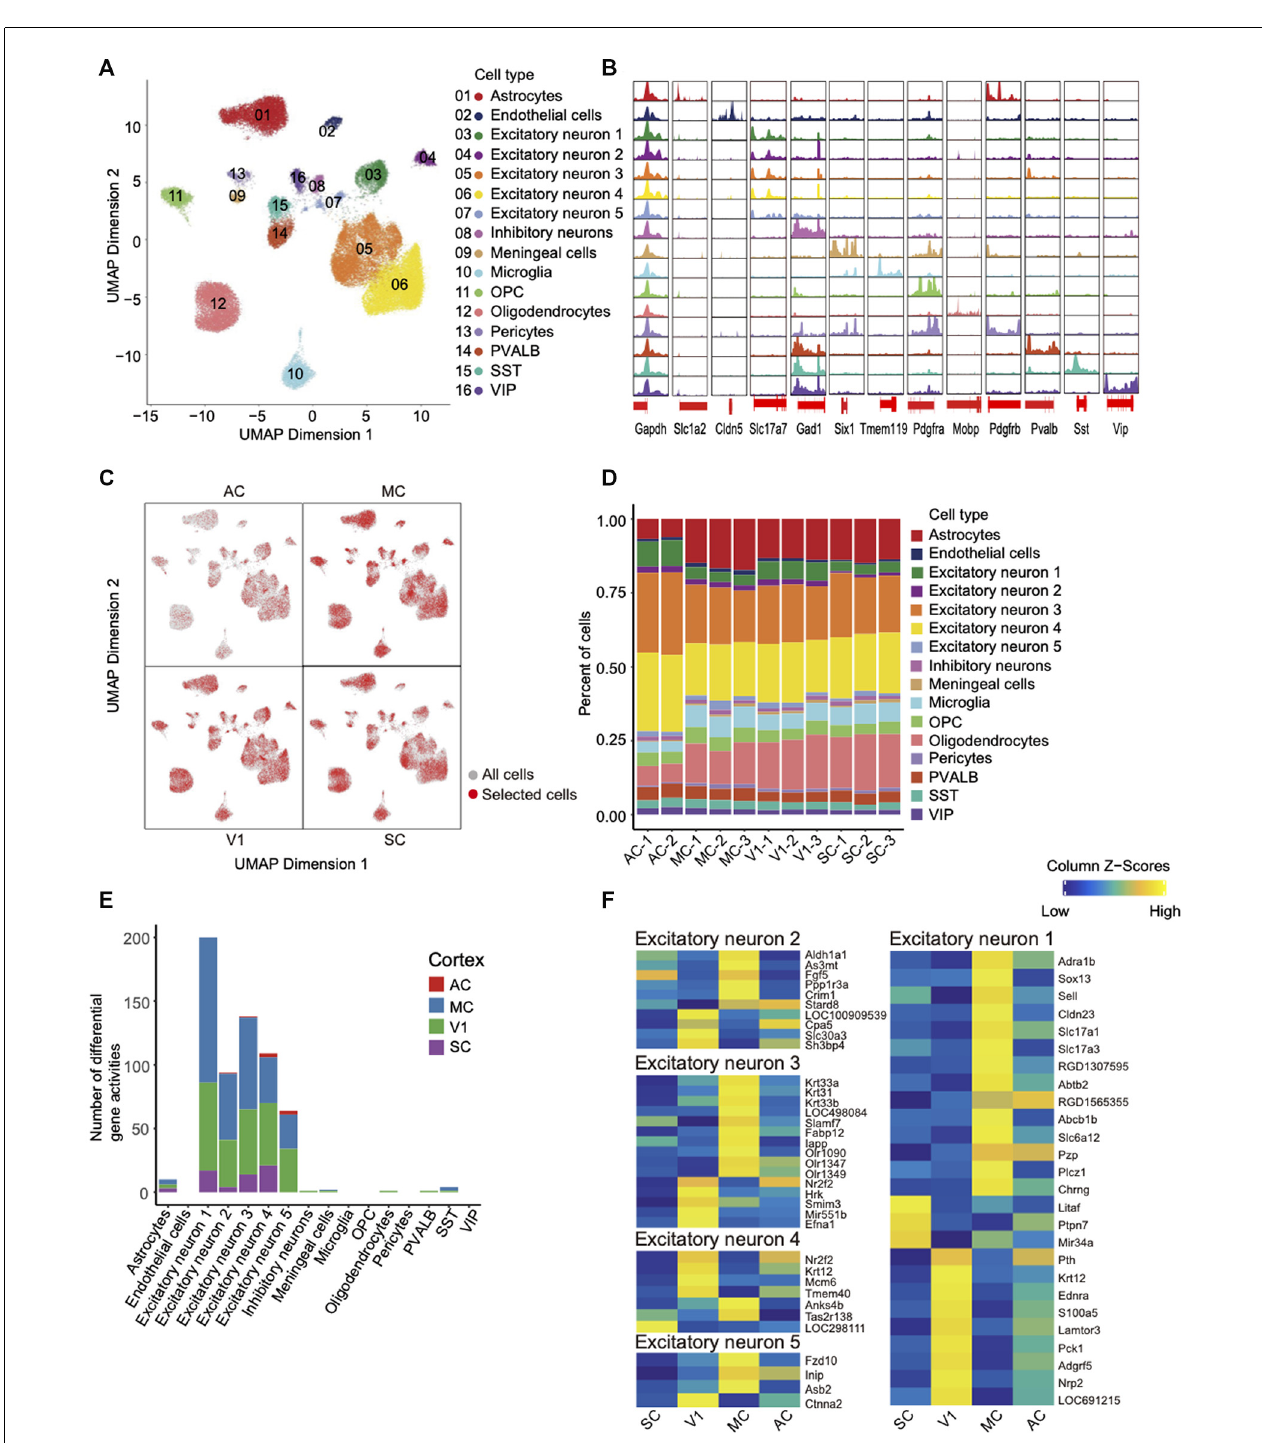
FIGURE 3 | Single-cell chromatin accessibility of rat cortex and inter-regional diversity of excitatory neurons. (A) UMAP of snATAC-seq data showing 16 clusters. A total of 59,023 nuclei passed QC and were used for clustering rat cortices into neuronal and non-neuronal cell types. Each cluster is color-coded to distinguish specific cell types. (B) Genome browser views of snATAC-seq signal for the indicated housekeeping gene (Gapdh) and cell-type-specific genes. (C) UMAP expresses differences in cellular distribution across the four cortex regions, the red dots represent a specific region. (D) Histogram shows the number of cell types between each library in different cortices. (E) Histogram of the number of different genes between cortical regions within the same cell type. (F) Heatmap of gene activity scores for all genes in the four cortices of each excitatory neuron.